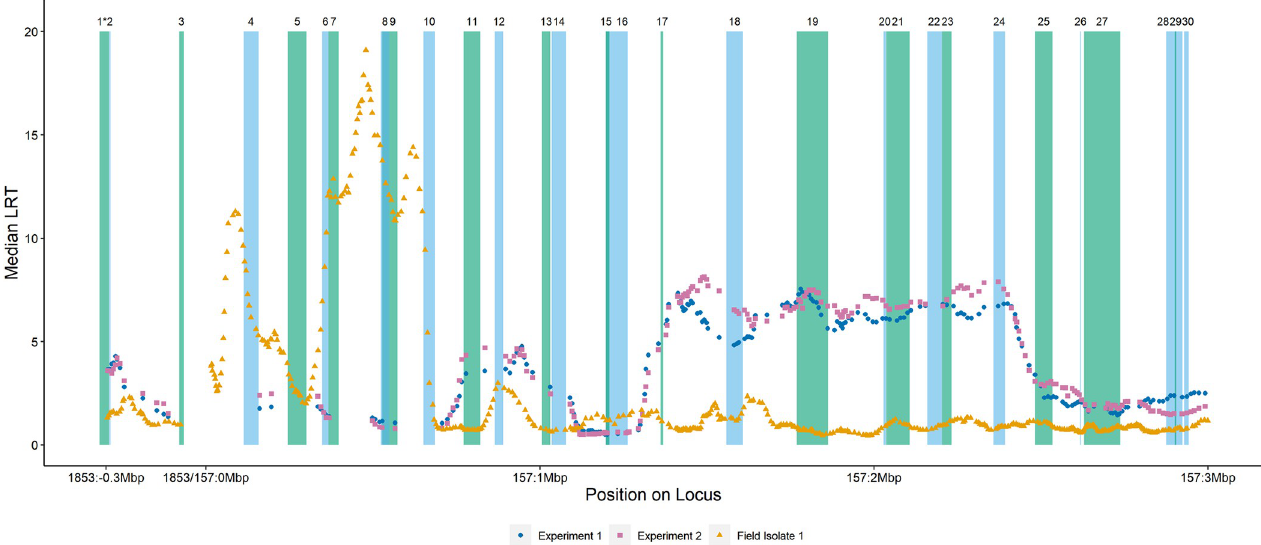
Fig 5. Median likelihood ratio test (LRT) statistic from generalised linear models within moving windows of 1000 informative SNPs for in vivo Experiment 1 and Experiment 2 and Field Isolate 1 are plotted against the position within the 3.2Mbp locus (0.3Mbp region of scaffold 1853 and a 2.9Mbp region of scaffold 157). Positions of the 30 genes are indicated across the locus and are represented in alternating green and blue colours to allow visualisation. Gene numbering corresponds with Table 5: 1: maker-scaffold10x_1853_pilon-snap-gene-0.15 (26S proteasome non-ATPase regulatory subunit 14; � gene crosses locus boundary); 2: maker-scaffold10x_1853_pilon-snap-gene-0.14 (26S proteasome non-ATPase regulatory subunit 14); 3: maker- scaffold10x_1853_pilon-snap-gene-0.13 (Uncharacterised protein); 4: maker-scaffold10x_157_pilon-snap-gene-0.196 (EGF-like protein); 5: